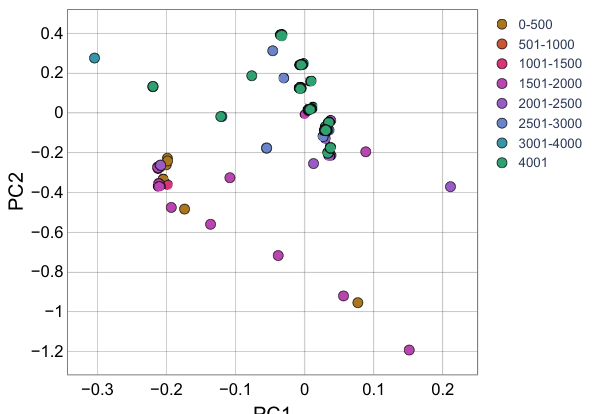
Figure 2. Principal component analysis using the 2 main Principal Components for the phylogenetic distances. Each point represents one subject, its color corresponds to the altitude group.